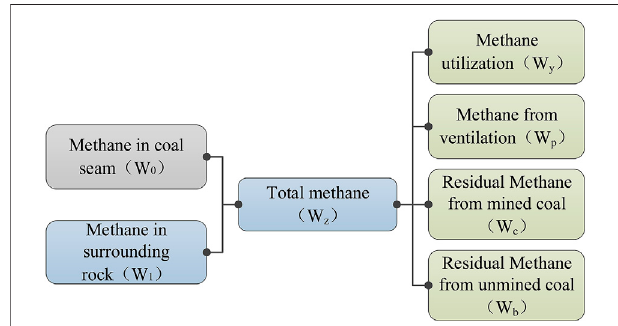
FIGURE 3 | Source – sink relationship of CH 4 in coal production enterprises.